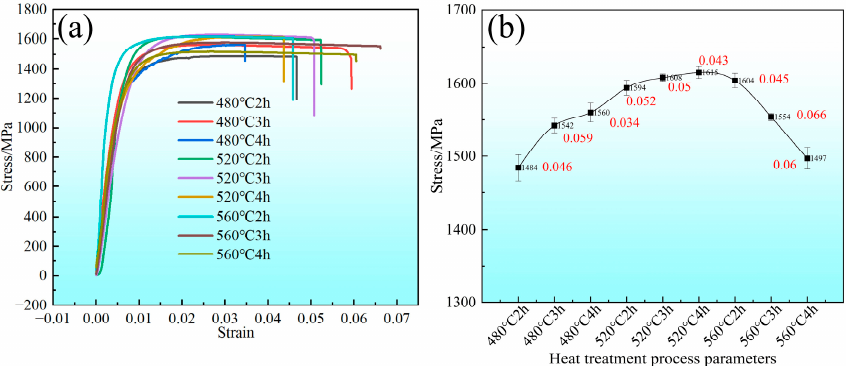
Figure 6. The stress–strain curves ( a ) and stress changes ( b ) according to heat treatment parameters of STACER formed by the winding and stabilization process (elongation: red number).